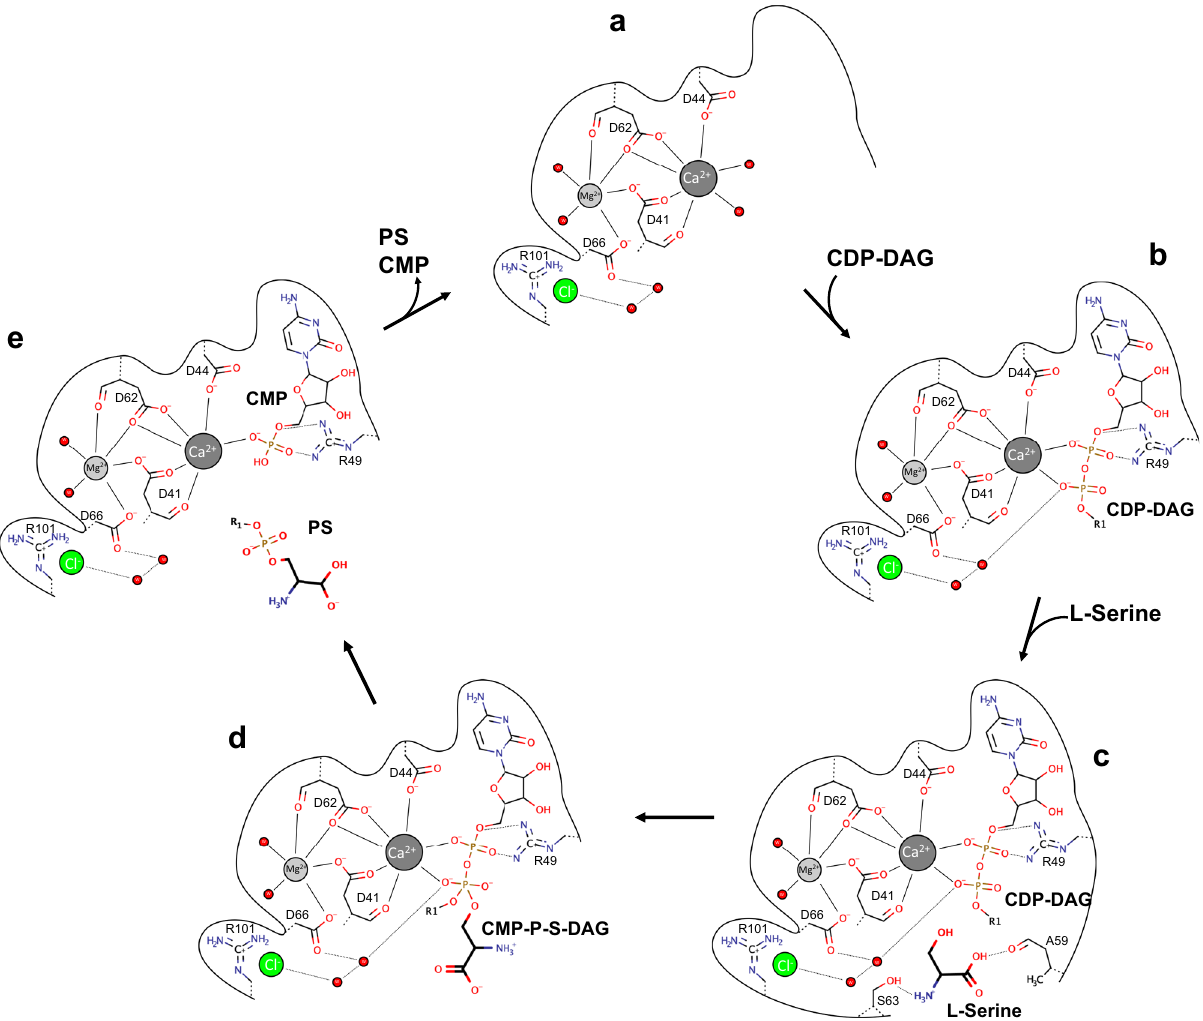
Fig. 6 Reaction mechanism. Reaction cycle of MjPSS during the synthesis of PS from CDP-DAG and serine in the presence of Mg 2 + and Ca 2 + . The CDP- DAG binding site in MjPSS of is formed and stabilized by the divalent cations Mg 2 + and Ca 2 + ( a ). In the absence of CDP-DAG, Ca 2 + most likely is coordinated by water molecules, as shown in a , or by residues in nearby loops that would be fl exible in the absence of CDP-DAG. The binding of CDP-DAG ( b ) is driven by the coordination of Ca 2 + by the negatively charged phosphates. Serine binds to the binding pocket after CDP-DAG ( c ). For the nucleophilic attack, the serine molecule is positioned with its hydroxyl group near the β -phosphate of CDP-DAG. The serine molecule is activated by deprotonation, attacks the β -phosphate and forms the penta-coordinated transition state ( d ). The proton of serine is probably removed by one of the water molecules located in the interaction network of Asp66, Arg101, and the nearby chloride ions. Hydrolysis of the CDP-DAG/serine complex from the transition state leads to the complex of MjPSS with the products PS and CMP ( e ). The next cycle starts after release of the products and binding of CDP-DAG. Structural data are available for the state with bound CDP-DAG ( b ), CDP-DAG, and serine ( c ), and for the transition state of the CDP-DAG/serine complex ( d